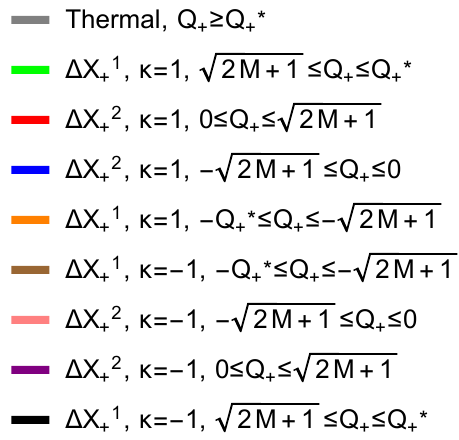
Figure 7 . Colour legend for geodesic plots. We have split the plot in eight segments depending on whether we have (cid:1) X (1 ; 2) +